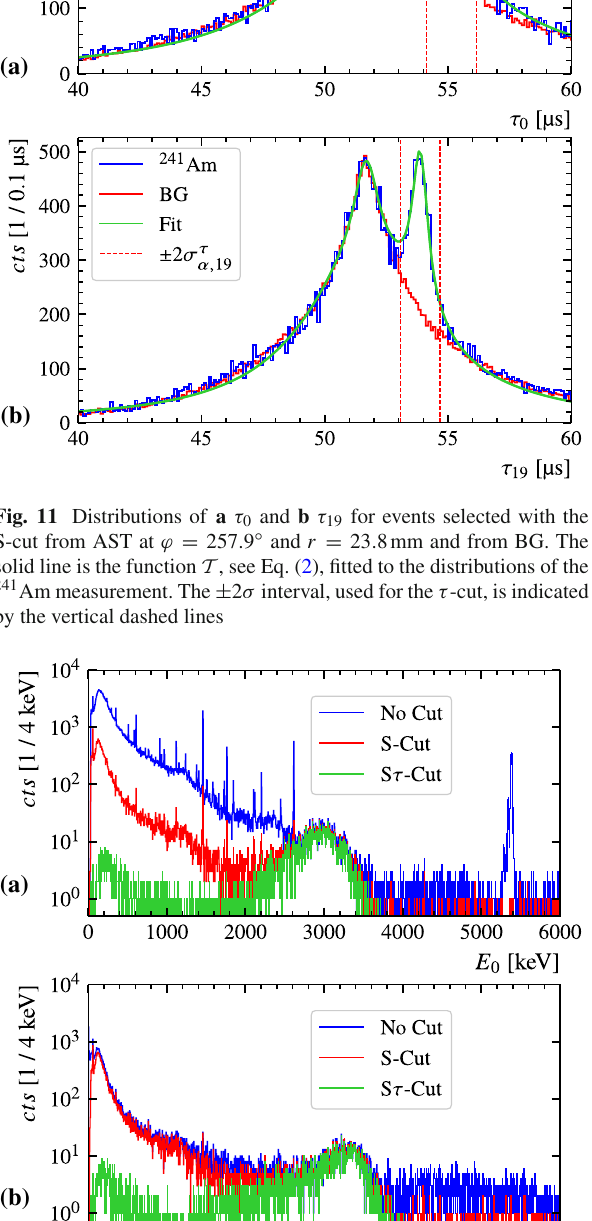
Fig. 12 Spectra of a E 0 and b E 19 before and after the application of the S-cut and S τ -cut for a measurement of the scan AST with the top beam-spot at ( ϕ = 257 . 9 ◦ , r = 23 . 8mm) and the side beam-spot at ( ϕ = 167 . 9 ◦ , z = 40 . 0mm)